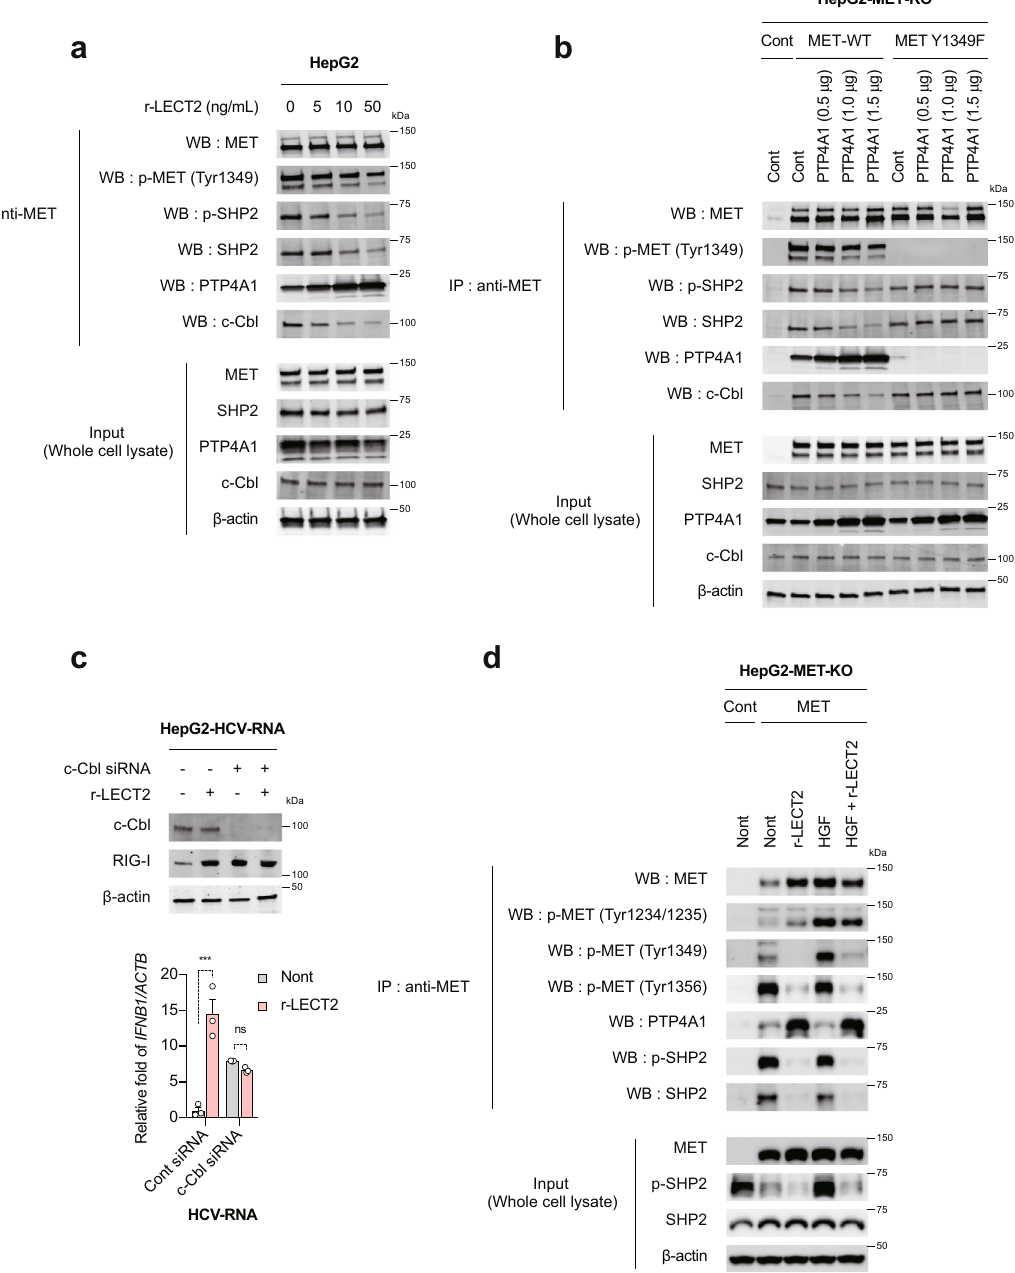
Fig. 8 PTP4A1 recruitment to MET is essential for LECT2-mediated RIG-I dependent innate immune responses. a HepG2 cells were treated with r-LECT2 (0, 5, 10, 50 ng/mL). At 6 h after treatment, lysates were immunoprecipitated with an anti-MET antibody. Immunoblot analysis of MET, p-MET (Tyr1349), p-SHP2, SHP2, PTP4A1, c-Cbl and β -actin in immunoprecipitated samples and input cell lysate. b HepG2-MET-KO cells were transfected with Control plasmid (Cont), MET WT plasmid, MET Y1349F plasmid, or PTP4A1 plasmid. At 48 h after transfection, lysates were immunoprecipitated with an anti-MET antibody. Immunoblot analysis of MET, p-MET (Tyr1349), p-SHP2, SHP2, PTP4A1, c-Cbl and β -actin in immunoprecipitated samples and input cell lysate. c HepG2 cells were transfected with 50 nM c-Cbl siRNA. The concentration of siRNA was adjusted to 50 nM with control siRNA. At 24 h after siRNA transfection, siRNA-transfected HepG2 cells were treated with 50 ng/mL r-LECT2 for 1 h and then transfected with HCV-RNA. c (upper) Immunoblot analysis of c-Cbl, RIG-I and β -actin at 12 h after HCV-RNA transfection. c (lower) qRT-PCR analysis of IFNB1 at 12 h after HCV-RNA transfection. Results were normalised to those of ACTB . Data shown are means of 3 technical replicates ± SEM. *** p < 0.001, not signi fi cant (ns) by two- way ANOVA with Tukey ’ s multiple comparison test. d HepG2-MET-KO cells were transfected with Control plasmid or MET plasmid; at 48 h after transfection, the cells were treated with 50 ng/mL r-LECT2 and/or 10 ng/mL HGF. At 1 h after r-LECT2 and/or HGF treatment, lysates were immunoprecipitated with an anti-MET antibody. Immunoblot analysis of MET, p-MET (Tyr1234/1235), p-MET (Tyr1349), p-MET (Tyr1356), PTP4A1, p-SHP2, SHP2 and β -actin in immunoprecipitated samples and input cell lysate. Source data are provided as a Source data fi